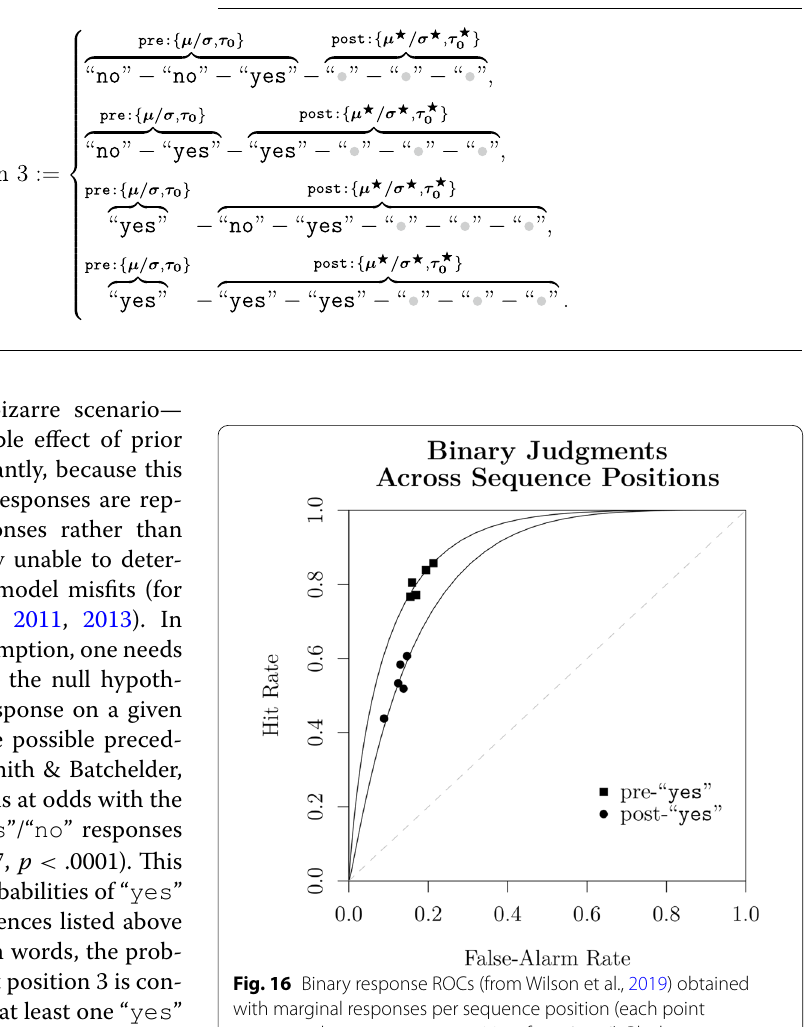
18 This structuring of the data still assumes all cases in which a “ yes ” response was previously made as i.i.d. This strikes us as a small price to pay given that we distinguish them from cases in which no such response has been